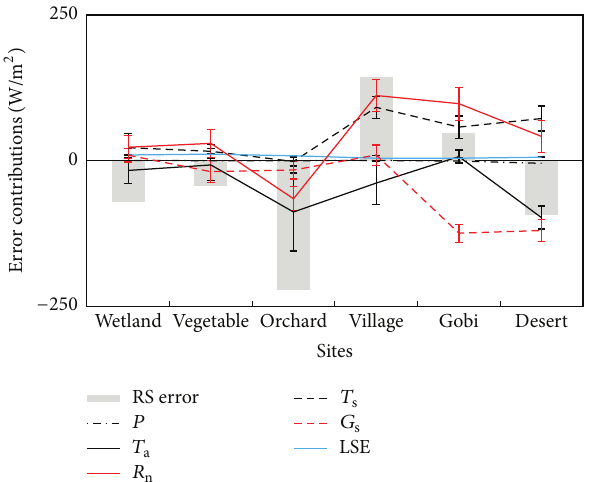
Figure 8: Error contributions of each factor, including the averages (line) and standard deviation (bar), along with errors of RSLE